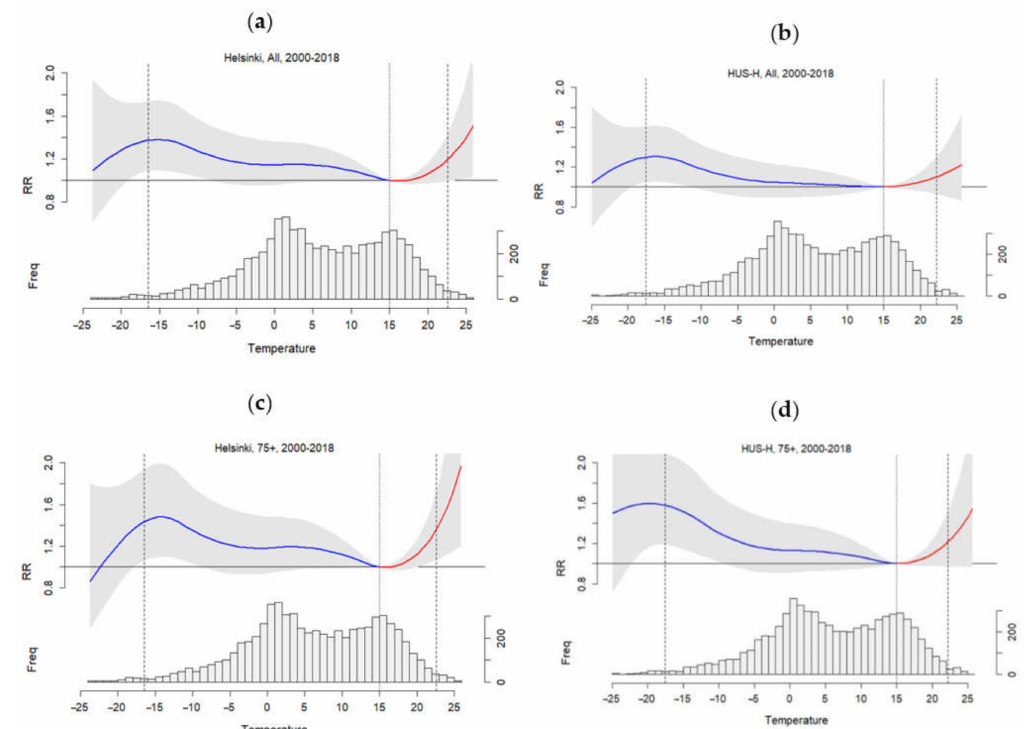
Figure 3. Overall cumulative mortality risks (RR) as a function or daily mean temperature and frequency distribution of daily mean temperature in 2000–2018. The association in Helsinki on left ( a , c ) and Helsinki-Uusimaa hospital district without Helsinki (HUS-H) on right ( b , c ). In the upper panels all ages ( a , b ) and in the lower panels 75+ associations ( c , d ). The grey areas illustrate the 95% confidence intervals of the modelled relationships. The RR is with respect to the mortality at +15 ◦ C (vertical dotted line), the red part of the curve illustrates heat-related mortality risk and the blue part of the curve cold-related mortality risk. The vertical dashed lines indicate 1st and 99th percentile of the daily mean temperature frequency